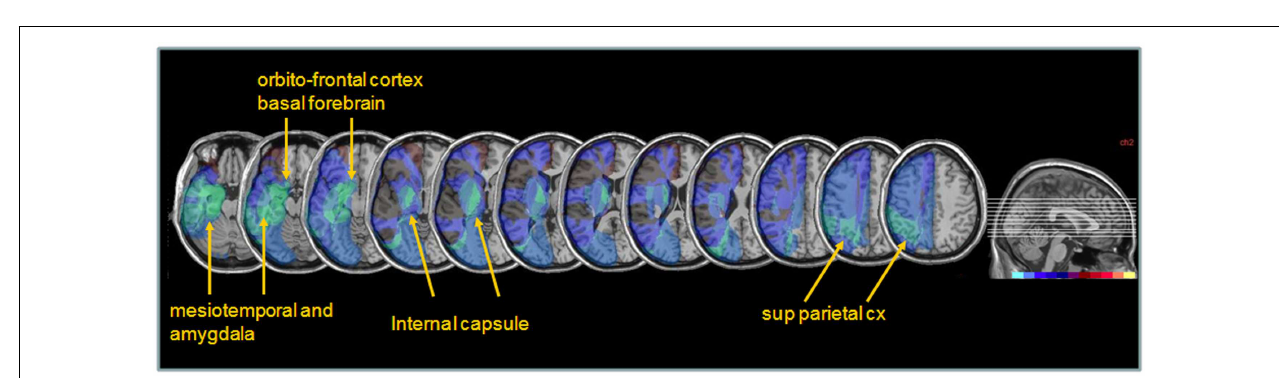
FIGURE 6 |Anatomical lesion analysis . (A) Lesion overlap for the 9/10 patients for whom CT or MRI scans were available. Colors code for the number of patients with damage to a given area, ranging from purple for areas affected in one patient only, to red for areas affected in all patients. Brain regions most consistently damaged in our patients were located in the posterior limb of the internal capsule and deep parietal lobe (orange-red, corresponding to at least eight patients). (B) Lesion overlap in a subgroup of four patients with the most severe neglect deficits at baseline showing more extensive lesions in the right peri-sylvian and subcortical temporo-parietal junction. (C) Lesion overlap in the five patients with less severe neglect